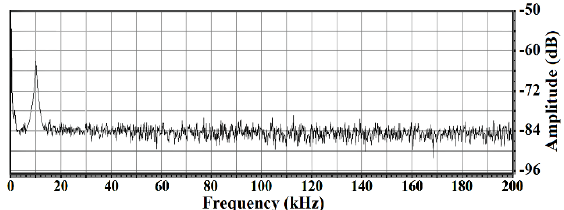
Figure 8. Amplitude spectrum of the homodyne LDV output with the air–water surface.